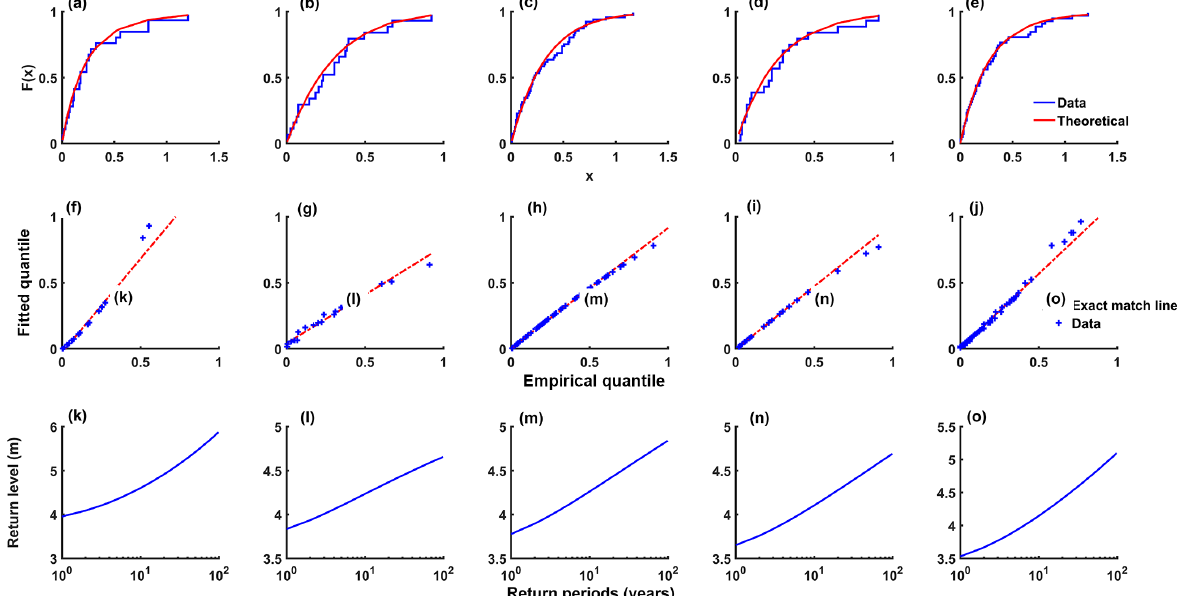
Figure 6. Same as in Fig. 4 but corresponding to the monsoon